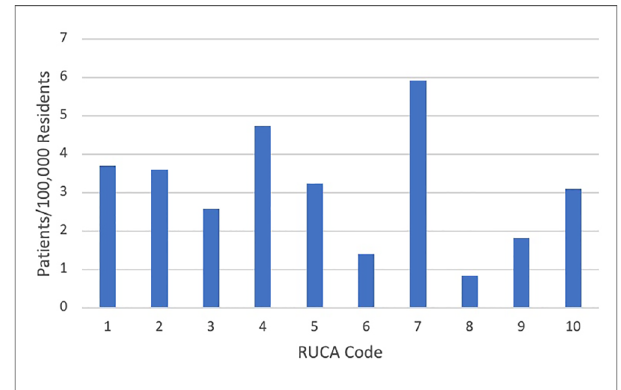
FIGURE 1 Proportion of vascular malformation patients by RUCA